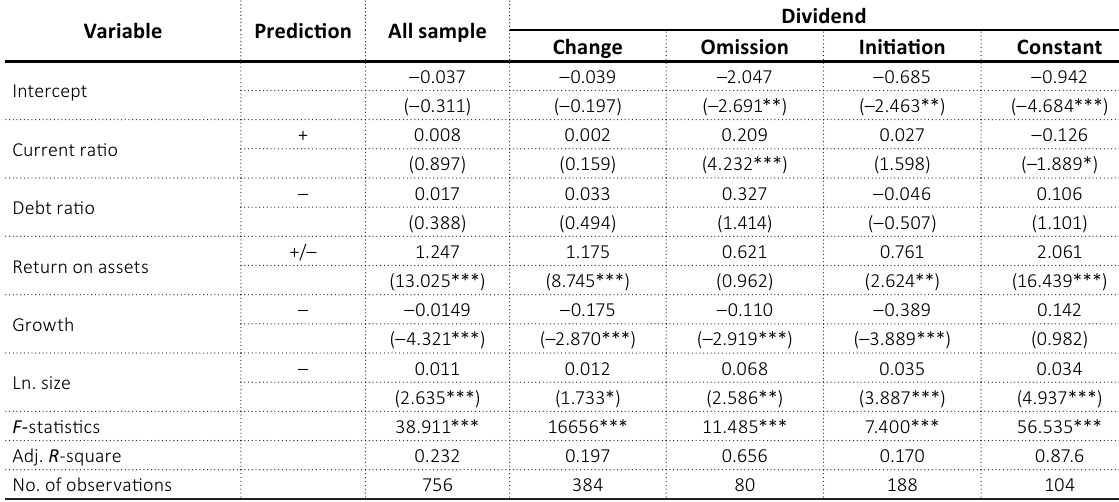
Table 5. Pooling data regression of cash dividend policy